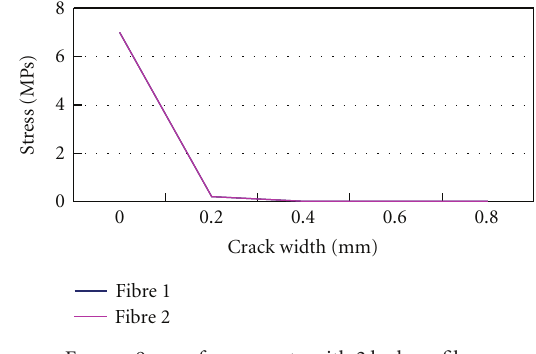
Figure 9: σ -w for concrete with 2kg long fiber.